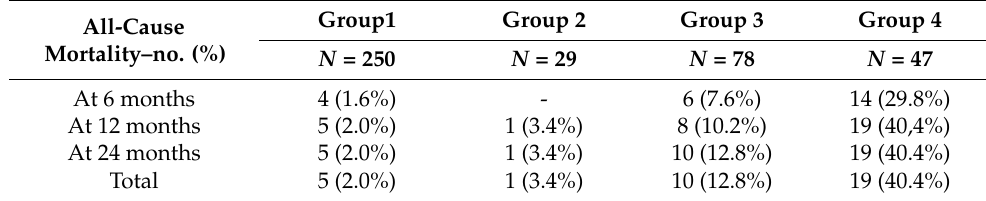
Table 2. Mortality rate in patients with pulmonary embolism (PE).